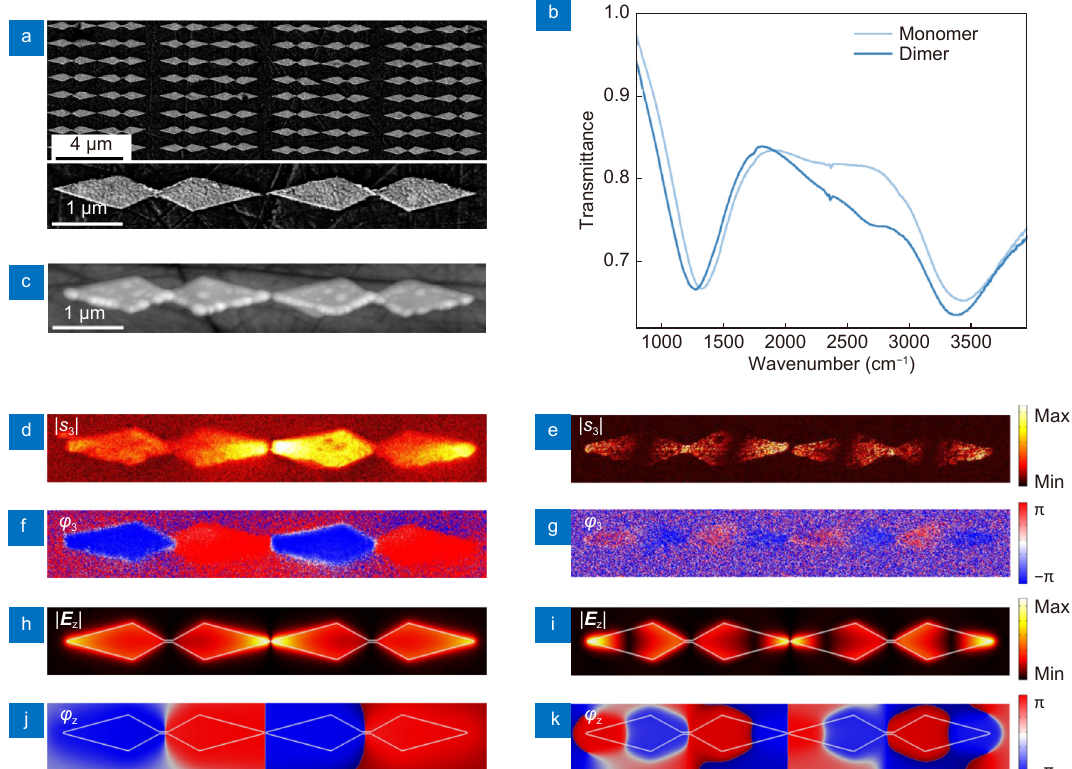
Fig. 6 | ( a ) SEM image of NBRA dimer. ( b ) Experimental transmittance of a NBRA and its dimer with gap size 20 nm. ( c ) AFM topography of a NBRA dimer. The scale bars in (a) and (c) are 1 μm. Measured near-field amplitude ( d ) and phase ( f ) of NBRA dimer at 1100 cm −1 . Simulated mapping of | E z | ( h ) and φ z ( j ) of NBRA dimer at 1100 cm −1 . Measured near-field amplitude ( e ) and phase ( g ) of NBRA dimer at 2100 cm −1 . Simu- lated mapping of | E z | ( i ) and φ z ( k ) of NBRA dimer at 2100 cm −1